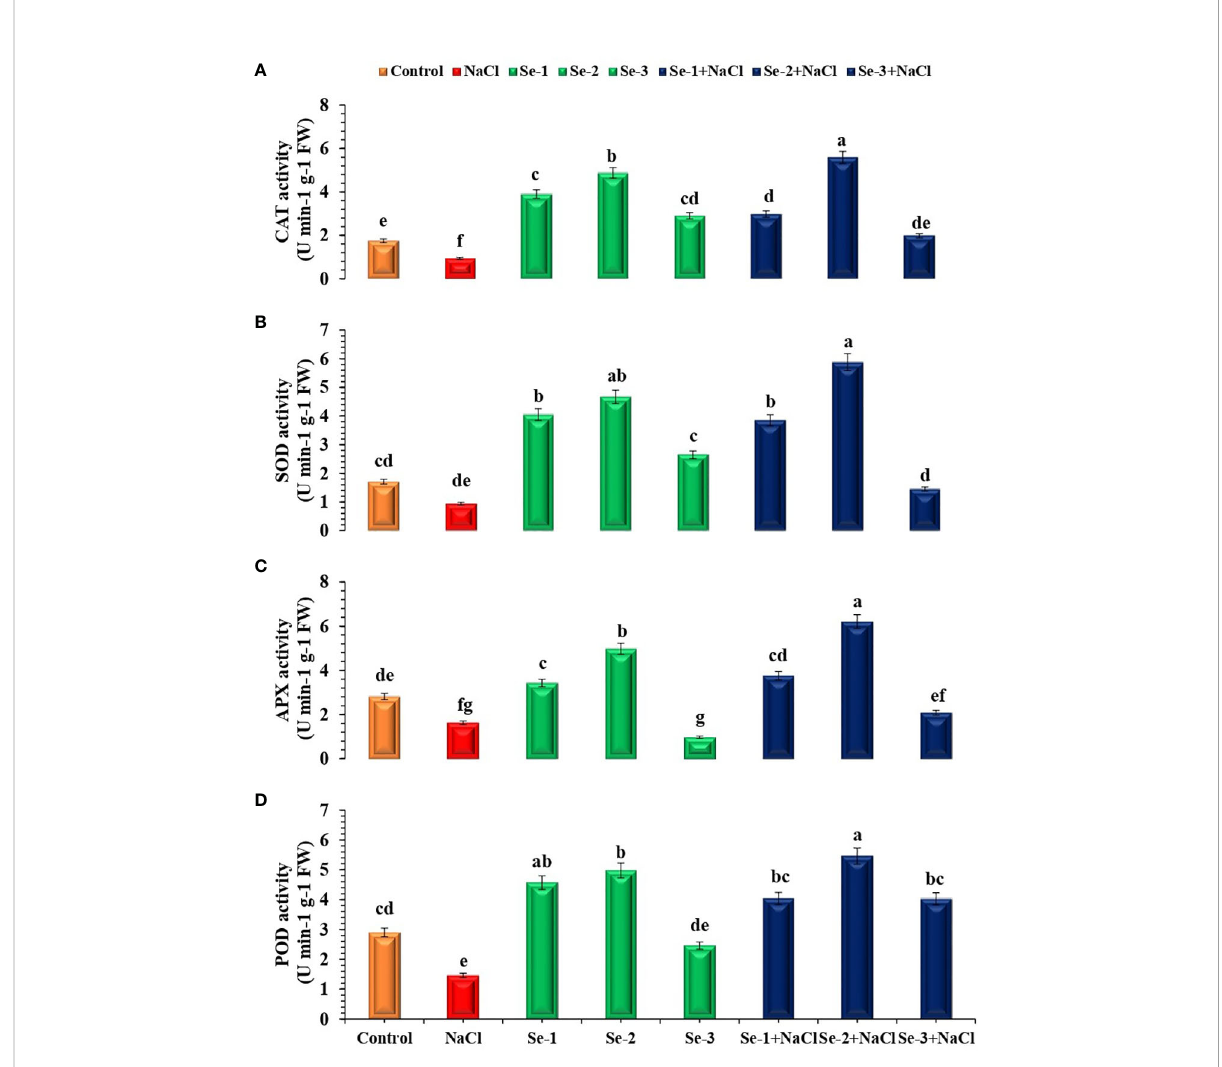
FIGURE 2 In fl uence of Se pretreatment on the antioxidant activity of Brassica rapa seedlings under saline conditions. (A) Catalase (CAT). (B) Superoxide dismutase (SOD). (C) Ascorbate peroxidase (APX). (D) Peroxidase (POD). Data presented are the mean ± SD of fi ve replications. Different letters denote signi fi cant differences between treatments at p ≤ 0.05. C , control. NaCl = 200 mM NaCl; Se-1 = 75 m mo L − 1 Se; Se-2 = 100 m mo L − 1 Se; Se-3 = 125 m mo L − 1